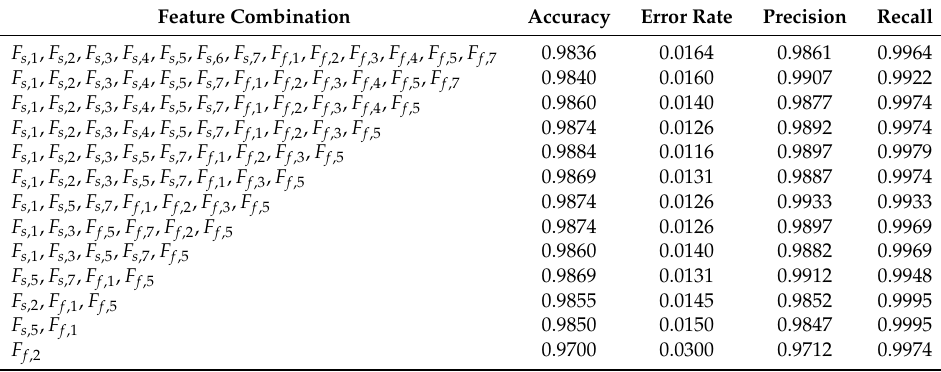
Table 6. Feature selection from the combination of F s and F f